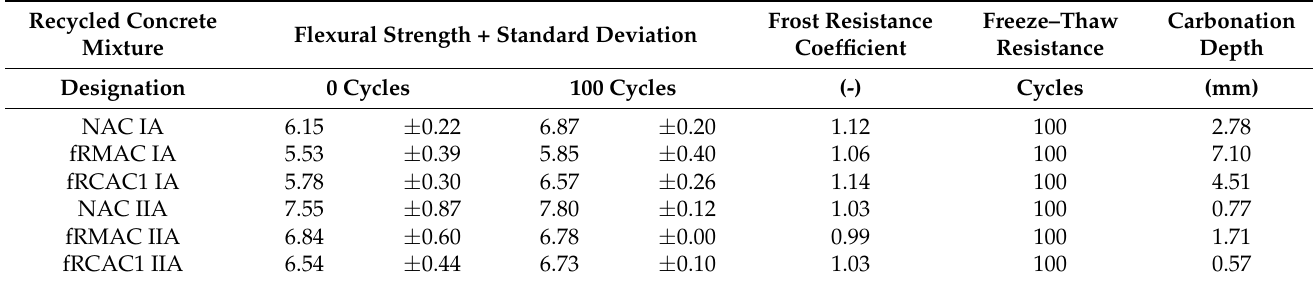
Table 4. Average values and standard deviation of evaluation of the flexural strength before and after freezing–thawing the frost resistance coefficient and carbonation depth of concrete mixtures.